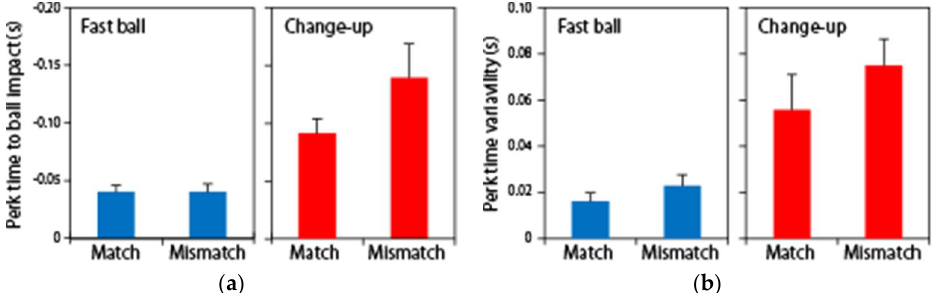
Figure 4. ( a ) Group mean of the peak time of the pelvis rotation velocity; ( b ) Group mean of the peak time of the pelvis rotation